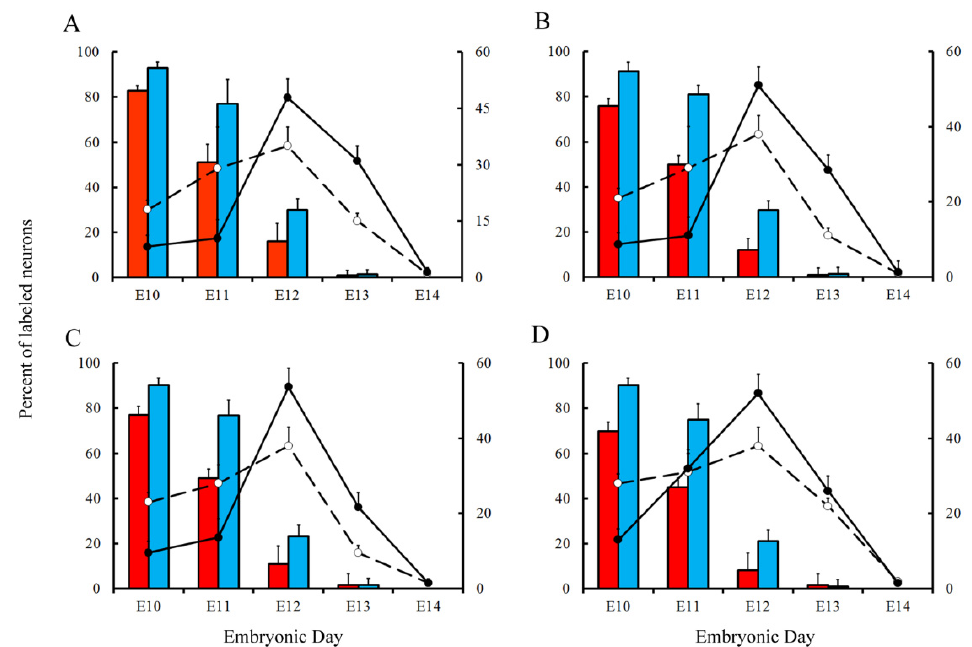
Figure 6. Comparison of Purkinje cells neurogenetic patterns in animals injected with bromodeoxyuridine (red columns) or [ 3 H]TdR (blue columns) at the level of the vermis ( A ), paravermis ( B ), medial ( C ), and lateral hemispheres ( D ). Developmental timetables of Purkinje cells were inferred using bromodeoxyuridine (open circles and dashed lines) or [ 3 H]TdR (closed circles and solid black lines). E: embryonic day. Values are expressed as mean ± SEM.